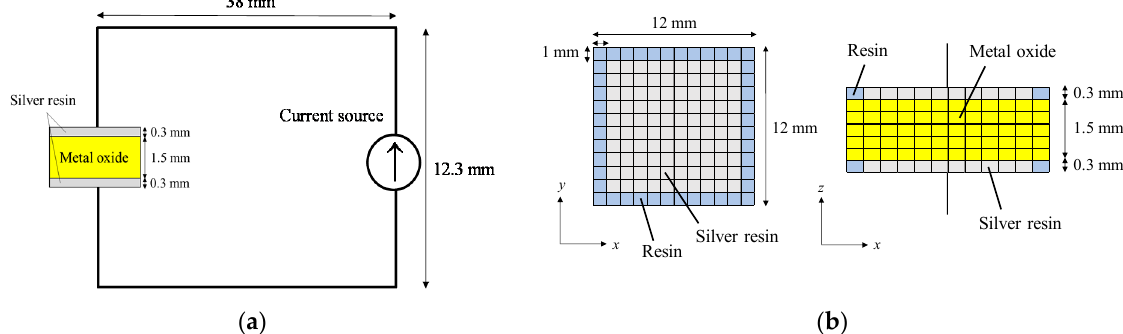
Figure 4. FDTD analysis model: ( a ) MOV element excited by a lumped current source, and ( b ) plan and side views of the MOV element.